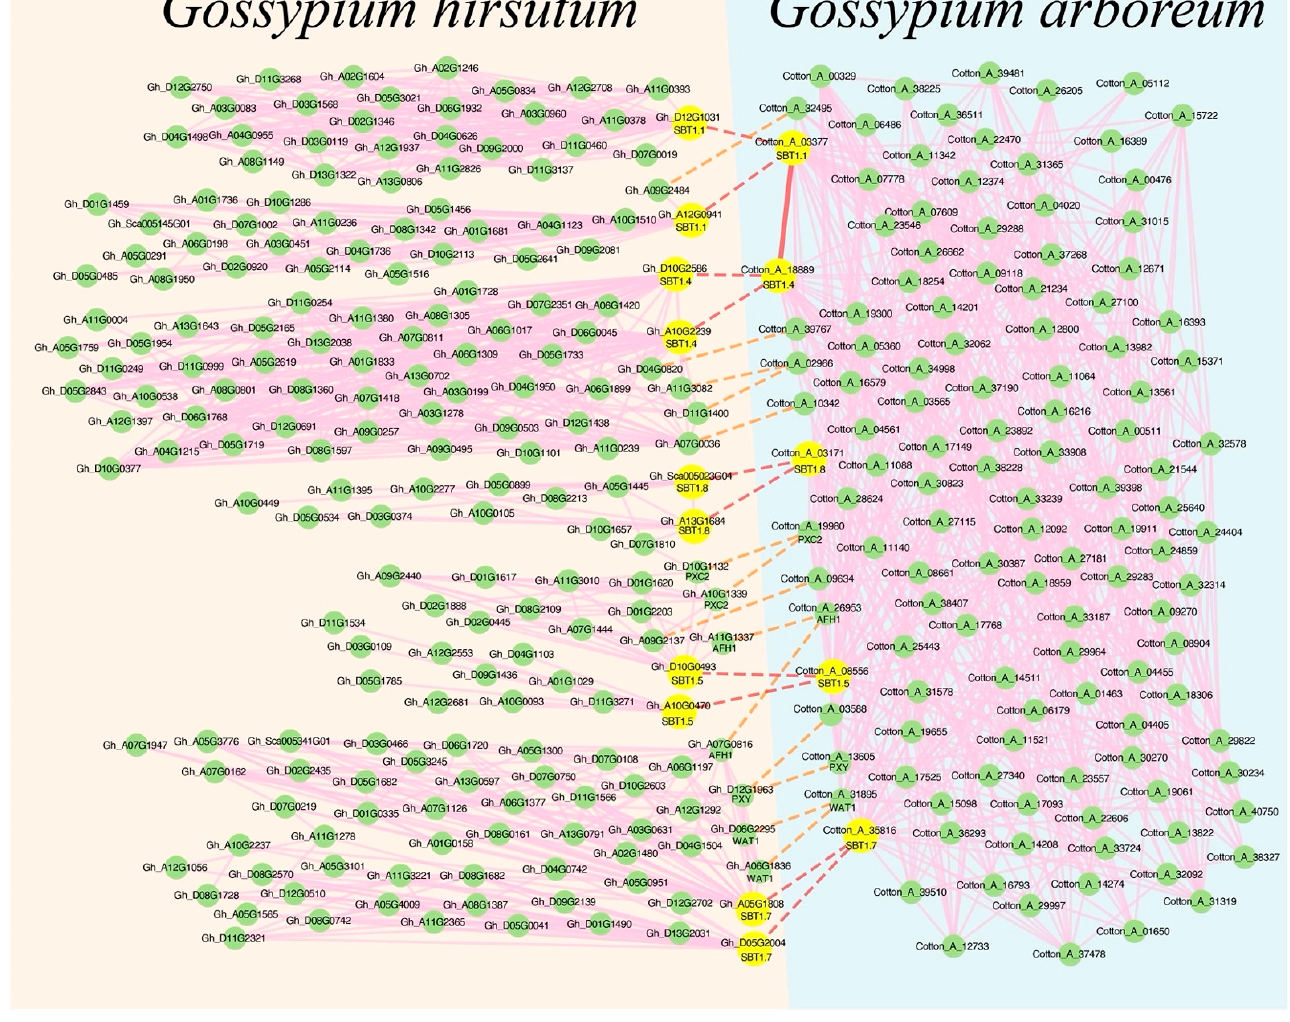
Figure 6. Comparison of SBT network between Gossypium arboreum and Gossypium hirsutum . The green nodes are co-expressed genes, and the large yellow nodes are Gossypium arboreum and Gossypium hirsutum SBT genes. Gossypium arboreum co-expressed network is blue background and Gossypium hirsutum is yellow. The pink line shows a co-expression relationship between two genes and the red line indicates SBT gene co-expression. The red dot line indicates that SBT is lineally homologous between two cotton species and the orange dot line indicates that co-expressed genes are lineally homologous between two cotton species.